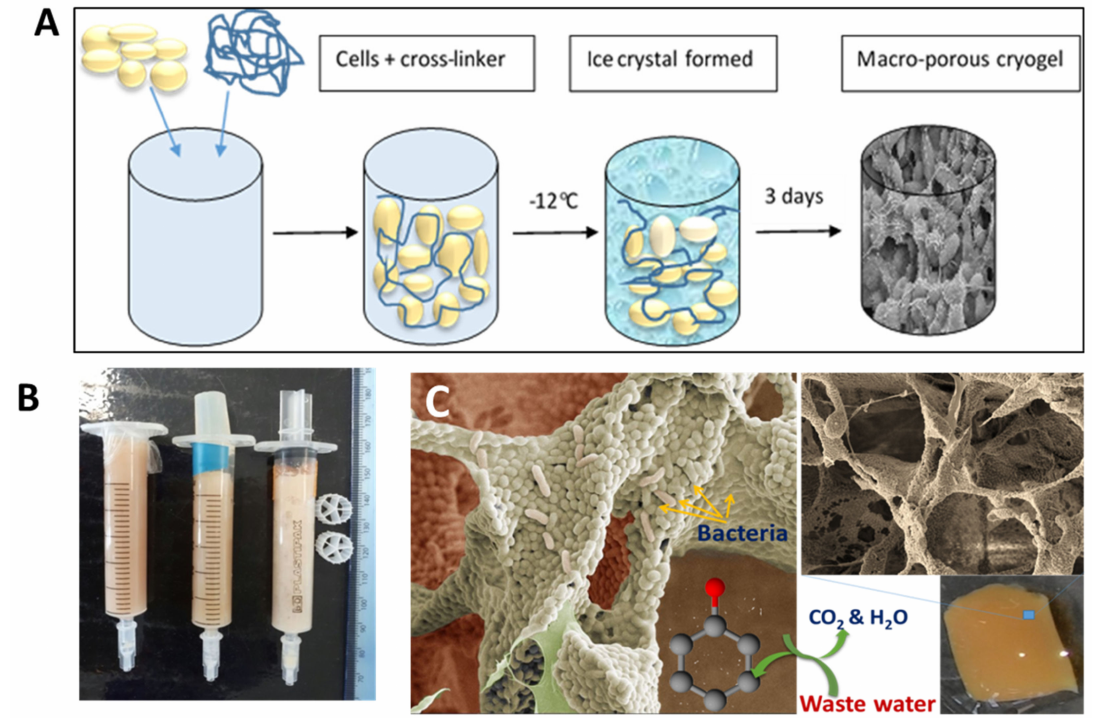
Figure 3. ( A ) Scheme of bacterial cryogel preparation, ( B ) bacterial cryogels prepared in syringes, and ( C ) SEM images of bacterial cryogel and scheme of phenol compound degradation. Figures are adapted from [62] with permission from the Royal Society of